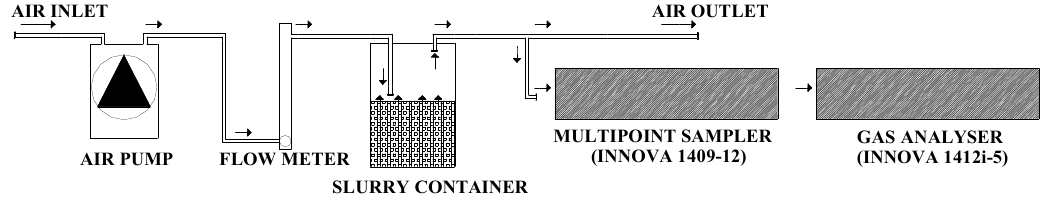
Figure 1. Schematic plan of the laboratory system used for measuring gaseous losses during the storage of pig slurry.